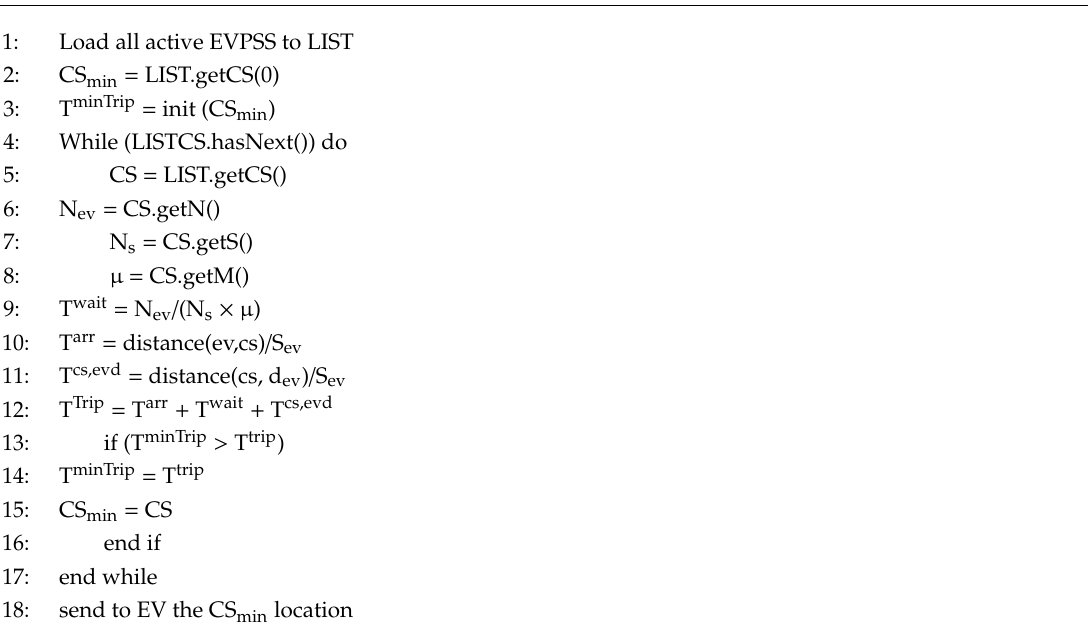
Algorithm 1: Decision of Selection the EVPSS